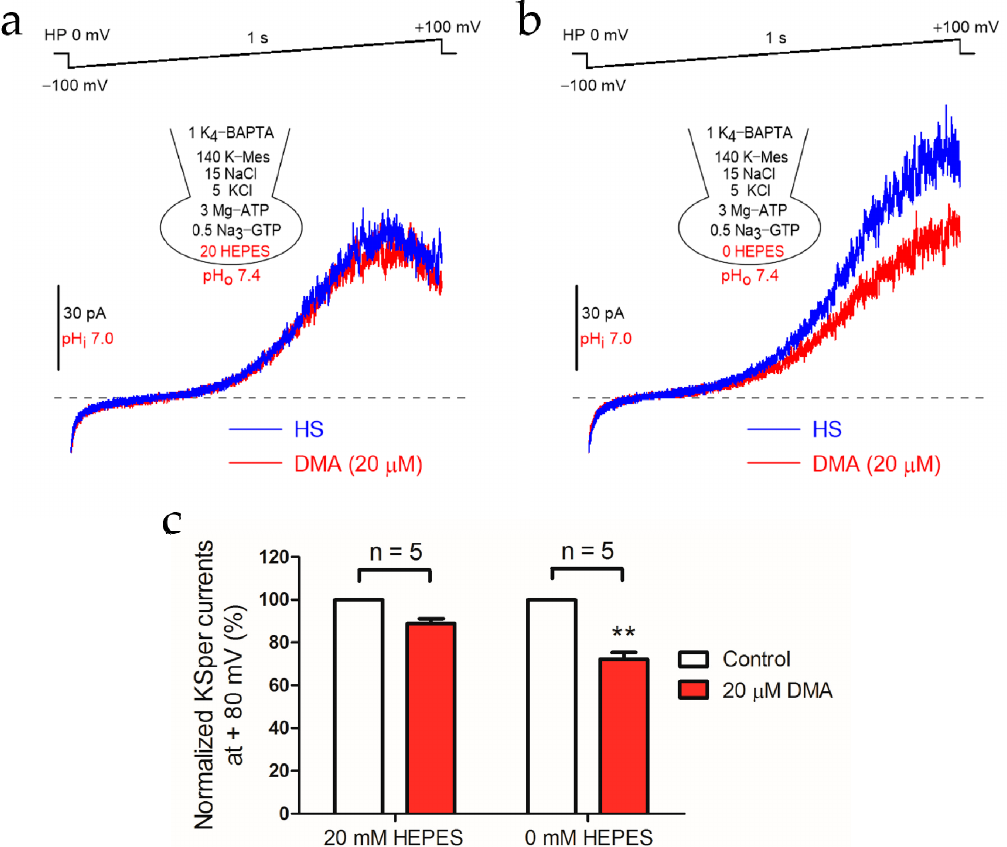
Figure 1. 5-( N , N -dimethyl)-amiloride (DMA) prominently reduced K + ion channel (KSper) currents after the removal of pH buffer in the pipette solution. Representative patch-clamp recordings of KSper currents in the absence or presence of 20 µ M DMA elicited by 1 s voltage ramp from − 100 mV to + 100 mV with a 20 mM 4-(2-hydroxyethyl)-1-piperazineethanesulfonic acid (HEPES) ( a ) or 0 mM HEPES ( b ) pipette solution at pH i 7.0. The high saline solution (HS) containing 135 mM Na + and 2 mM Ca 2+ was employed to maintain Na + /H + exchangers (NHEs) activity and block the CatSper current, respectively. ( c ) Statistical analysis of the mean normalized KSper currents at + 80 mV recorded in the pipette solution containing 20 mM HEPES ( n = 5) or 0 mM HEPES ( n = 5). Data are expressed as mean ± standard error of the mean (SEM). ** p < 0.01 (paired t -test).